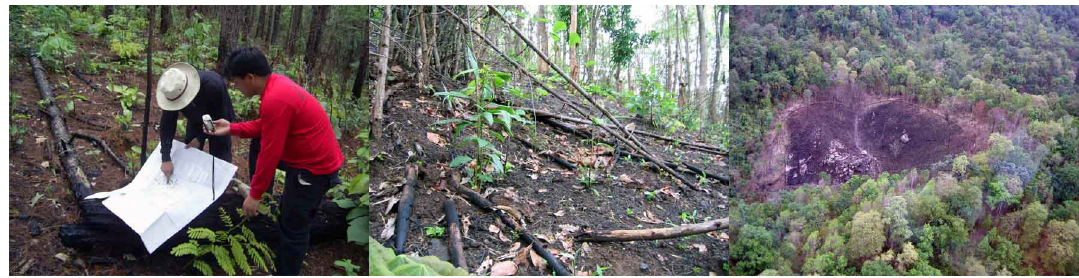
Figure 3 . Field validation